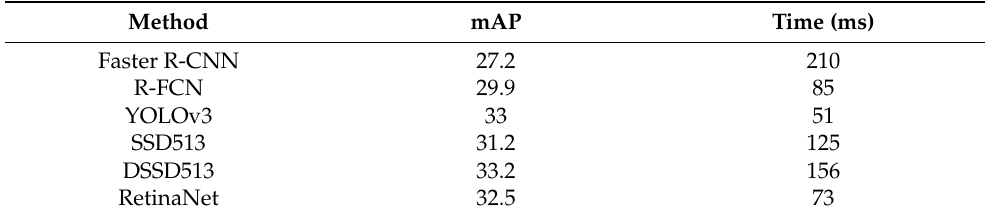
Table 7. Map and time of mainstream target detection algorithms.